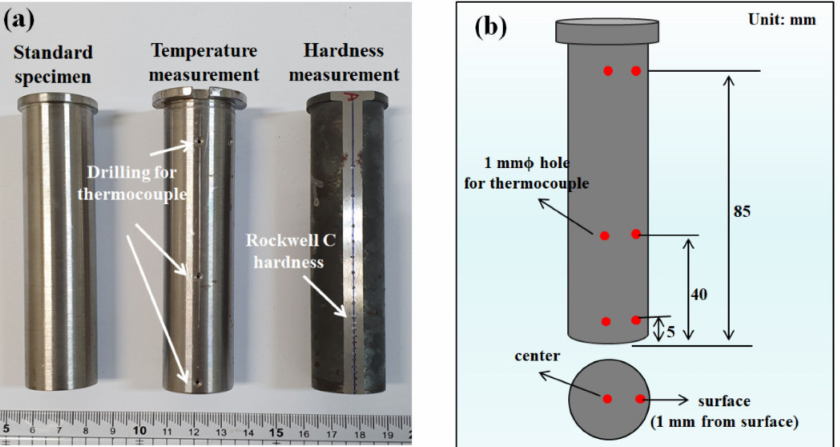
Figure 1. ( a ) Photograph of the Jominy specimen for temperature and hardness measurements and ( b ) schematic description of the measurement points of temperature in the Jominy end quench specimen using thermocouples in this study.